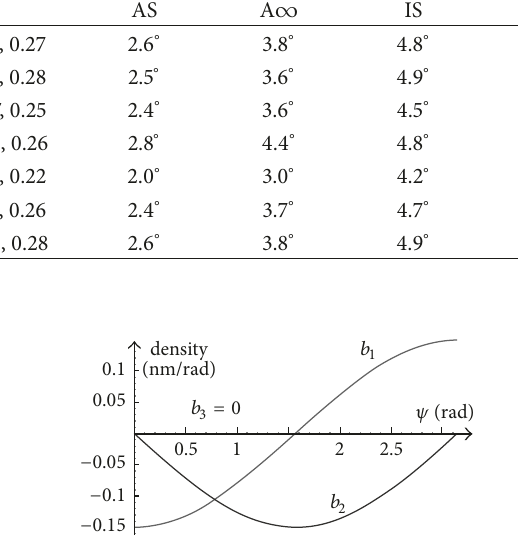
Figure 2: Case of the c screw TD oriented along the normal 𝑂𝑍